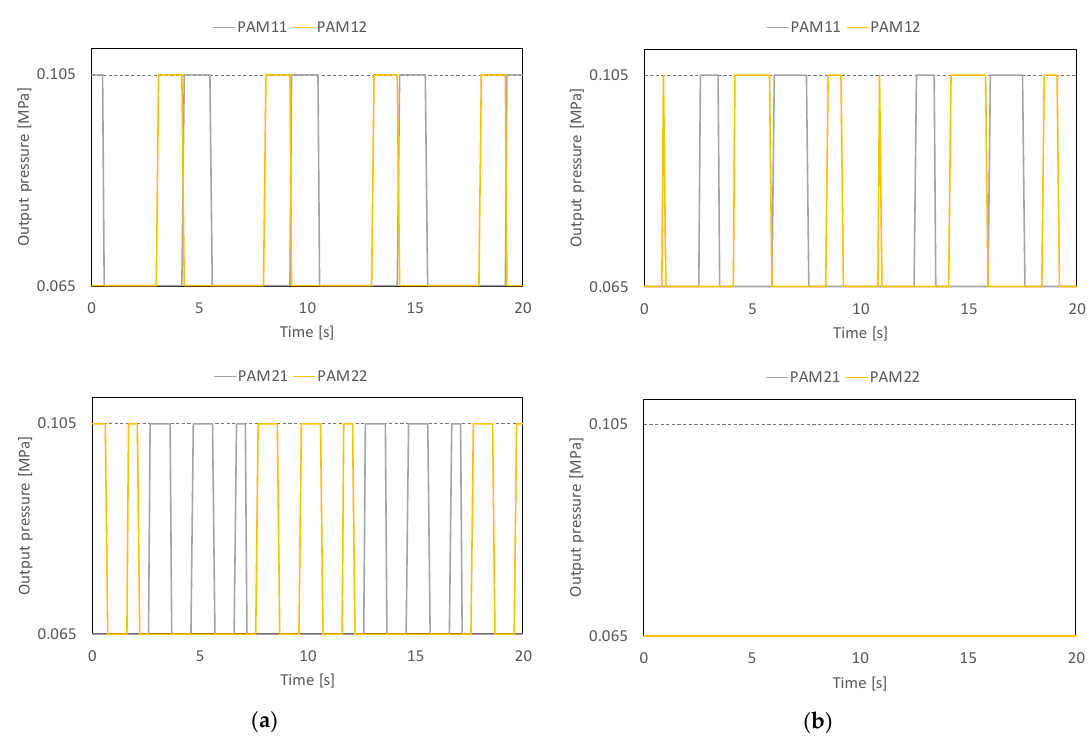
Figure 11. Cyclic inputs to PAMs using evaluation function 2 without load (( a ) first generation, ( b ) 18th generation).